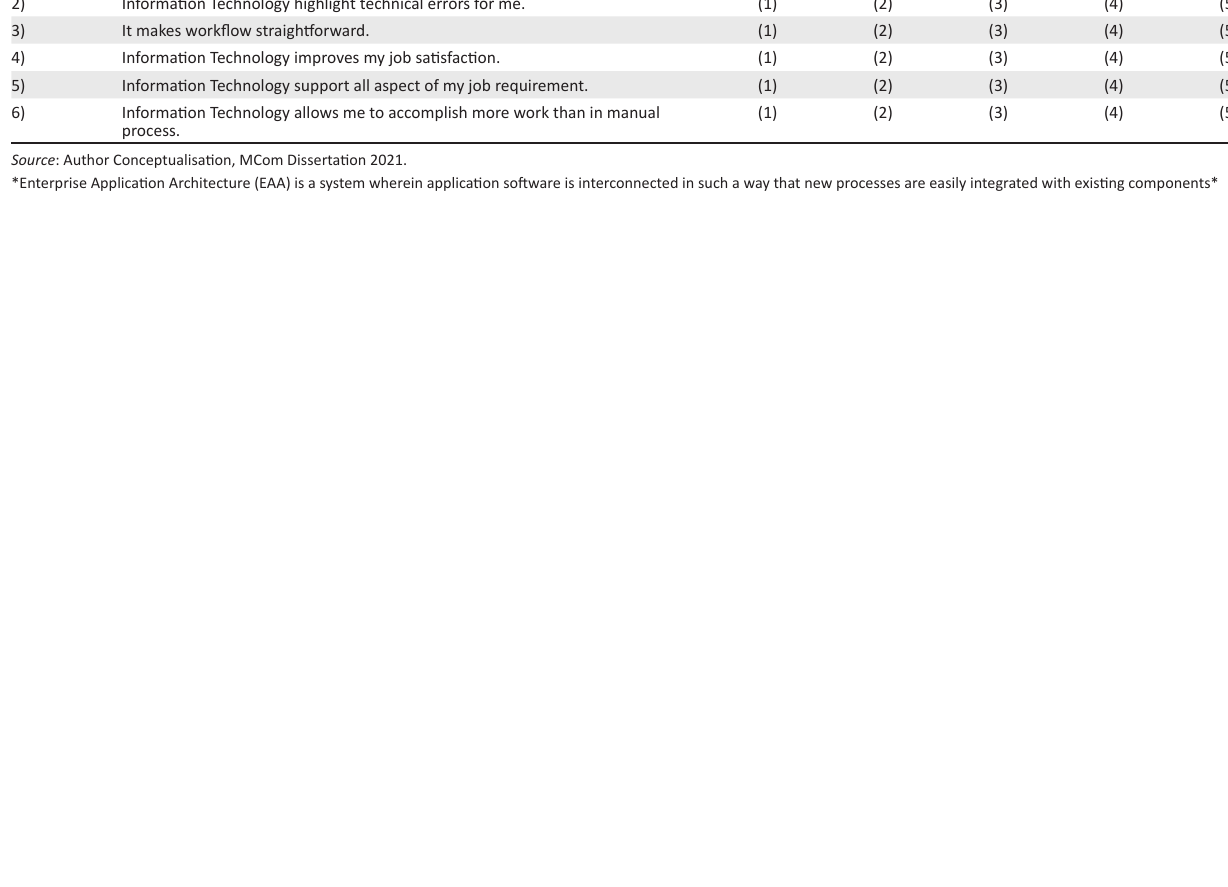
TABLE 1-A2: Please indicate your agreement with the following statements for actual adoption of information systems such as Enterprise Application Architecture* (See bottom page). Sigma